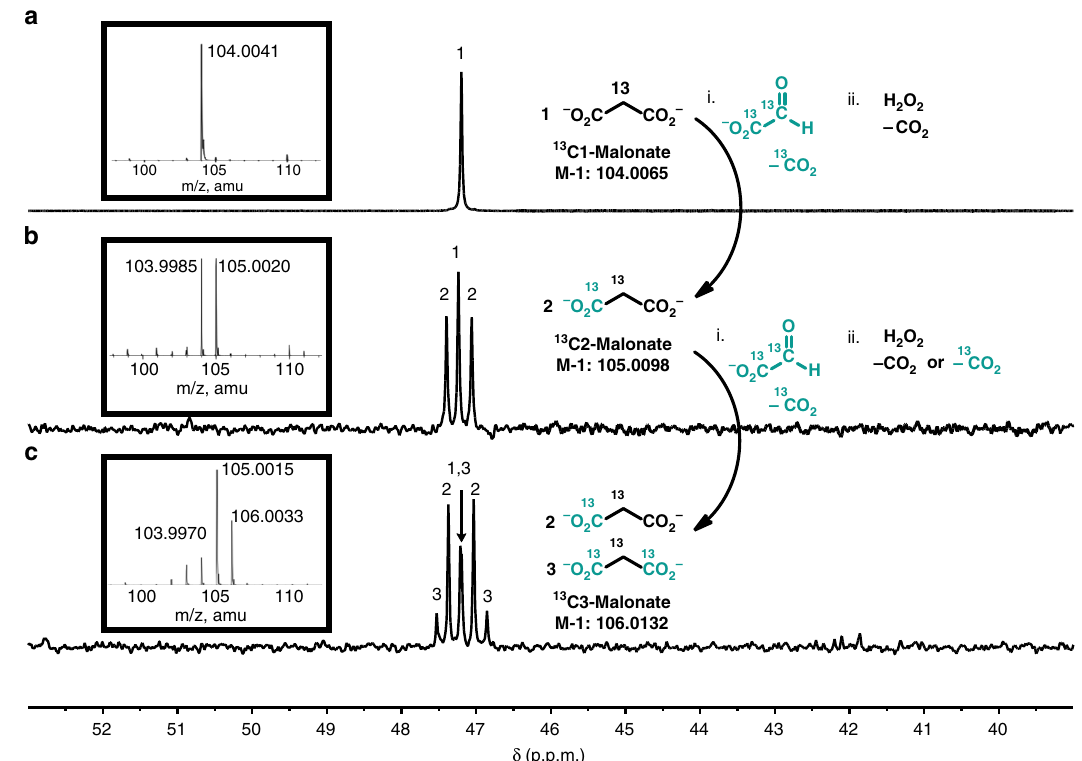
Fig. 6 The progression from mono- to di- to tri- 13 C-labeled malonate indicates two full iterations of the Malonate cycle. a 13 C NMR (in D 2 O) of a reaction aliquot from 2.0 ml of 200 mM (2- 13 C1)malonic acid in 1.0 M aqueous NaHCO 3 . b A total of 2 eq. of (1,2- 13 C2)glyoxylic acid was added, and the reaction was stirred at 50 °C for 3 h. Then, 30 wt% aqueous H 2 O 2 was subsequently added to the solution at a rate of 40 eq./h, and the reaction was stirred at 50 °C for 10 h. c The reaction volume was reduced under vacuum back to 2.0 ml, and the procedure was repeated starting from the addition of (1,2- 13 C2) glyoxylic